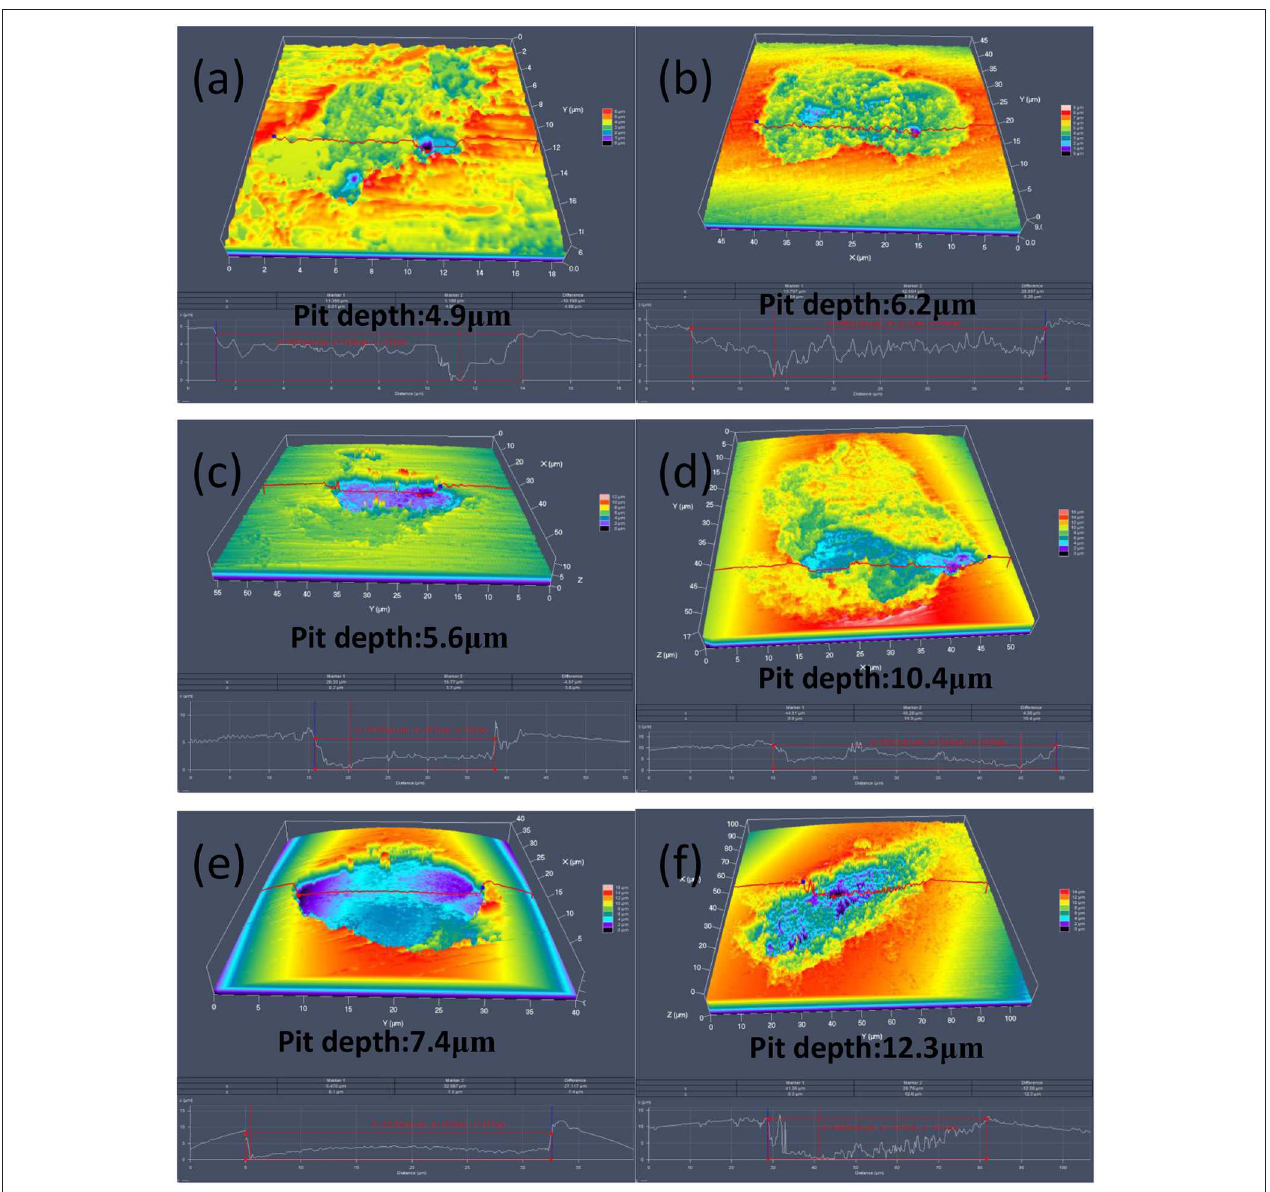
FIGURE 5 | Confocal laser scanning microscopy (CLSM) 3D images of pits on surfaces of coupons: (a) A1 base metal, (b) A1 weld seam, (c) A2 base metal, (d) A2 weld seam, (e) D1 base metal, and (f) D1 weld